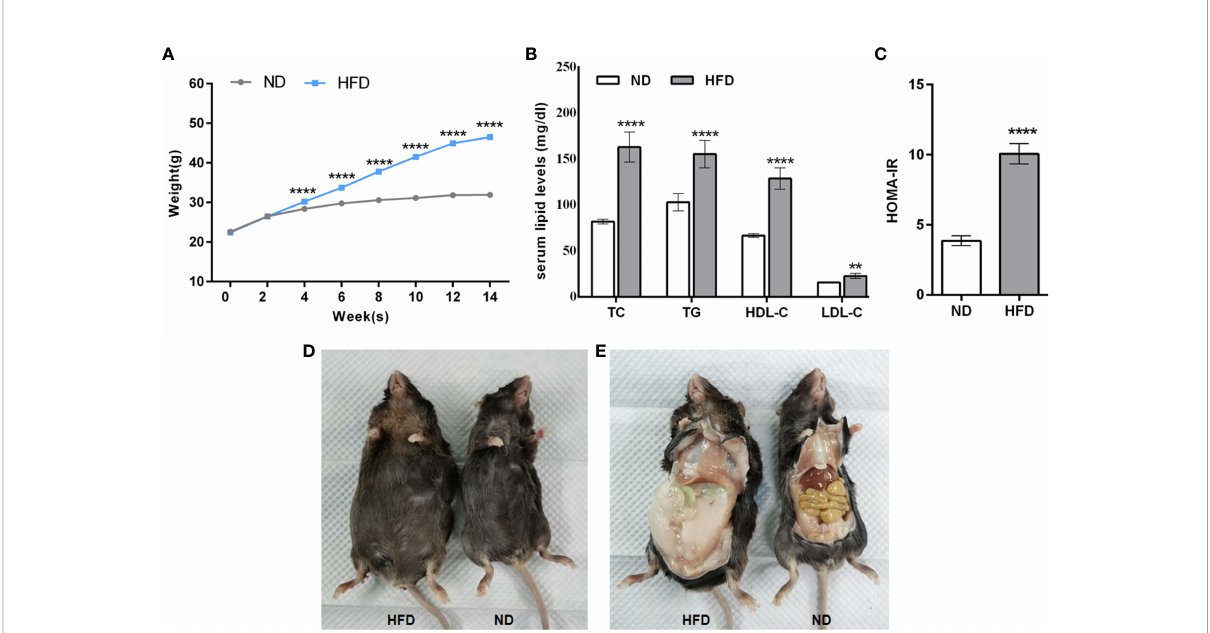
FIGURE 2 General conditions of mice fed with HFD. (A – C) The comparison of body weight, serum lipid levels, and HOMA-IR between mice fed with ND and HFD. (D, E) Comparison of body somatotype and adipose tissue between mice fed with ND and HFD. Data are represented as mean ± SEM. ND, n = 40; HFD, n = 140; (B, C) : n = 15; ** P < 0.01 vs ND, **** P < 0.0001 vs ND. ND, normal diet; HFD, high-fat